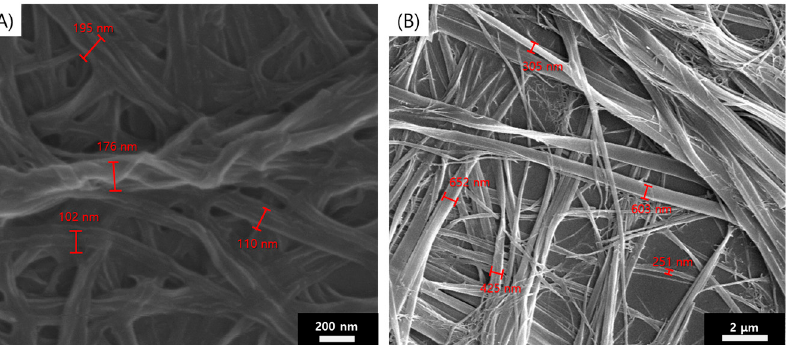
Figure 3. SEM images of in situ supramolecular gels prepared by 1 (3 wt %) and 2 (3 wt %) in ( A ) toluene and ( B ) n-hexane. ( A ) toluene and ( B )